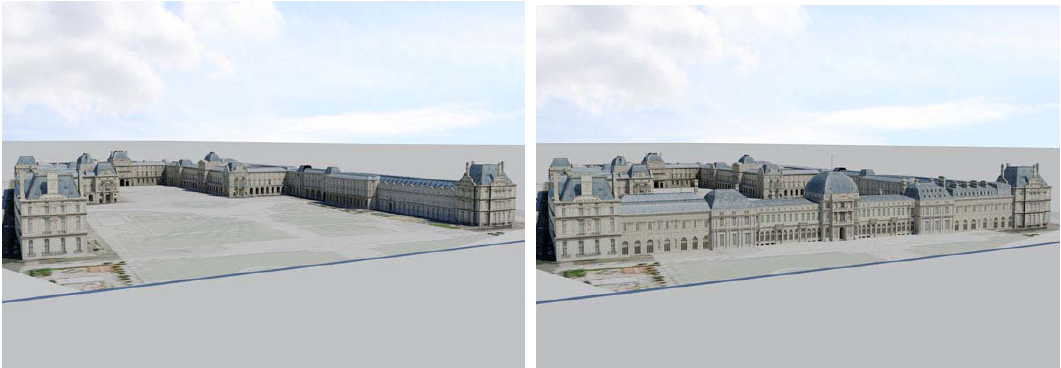
Fig. 11. Incrustation of the: (left) actual 3D model of “ Palais du Louvre ”. (right) the 3D model of “ Palais du Louvre ” including the 3D reproduction of “ Palais des Tuileries ” (demolished in